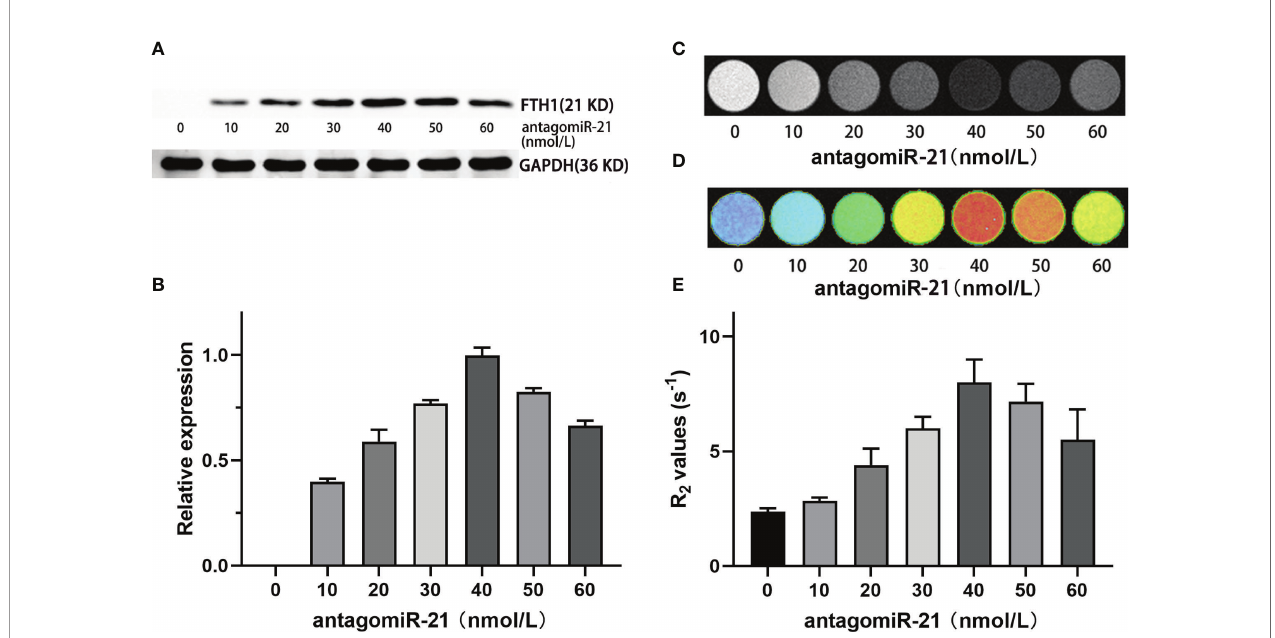
FIGURE 4 | Regulation of FTH1 expression by antagomiR-21. WB (A) and gray-scale (B) results show that the delivery of antagomiR-21 into cells reversed FTH1 expression in a dose-dependent manner. In the absence of antagomiR-21, no obvious FTH1 expression was detected in SK-N-SH/FTH1-3 × PT cells in which miR-21 suppressed the reporter gene by binding with the completely complimentary sequence of 3×C_miR-21. After transfection with antagomir-21, the expression of FTH1 increased gradually as the antagomir-21 concentration increased, peaking at 40 nmol/L, and then slightly decreased as the antagomiR-21 concentration continuously increased. The cellular MRI T2WI (C) , T2 map (D) and R2 measurements (E) in cells treated with different concentrations of antagomiR-21 were consistent with the WB